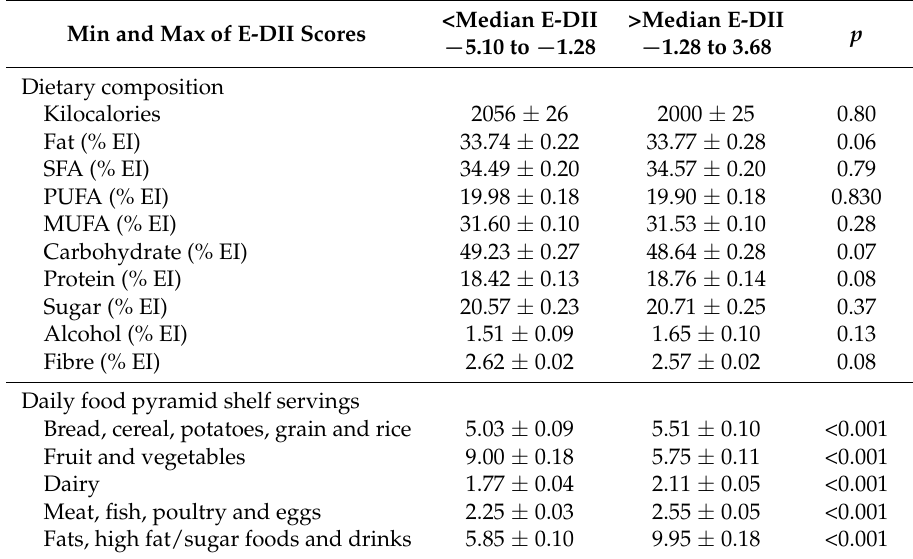
Table 2. Nutritional intake of the study population ( n = 1992) stratified by E-DII